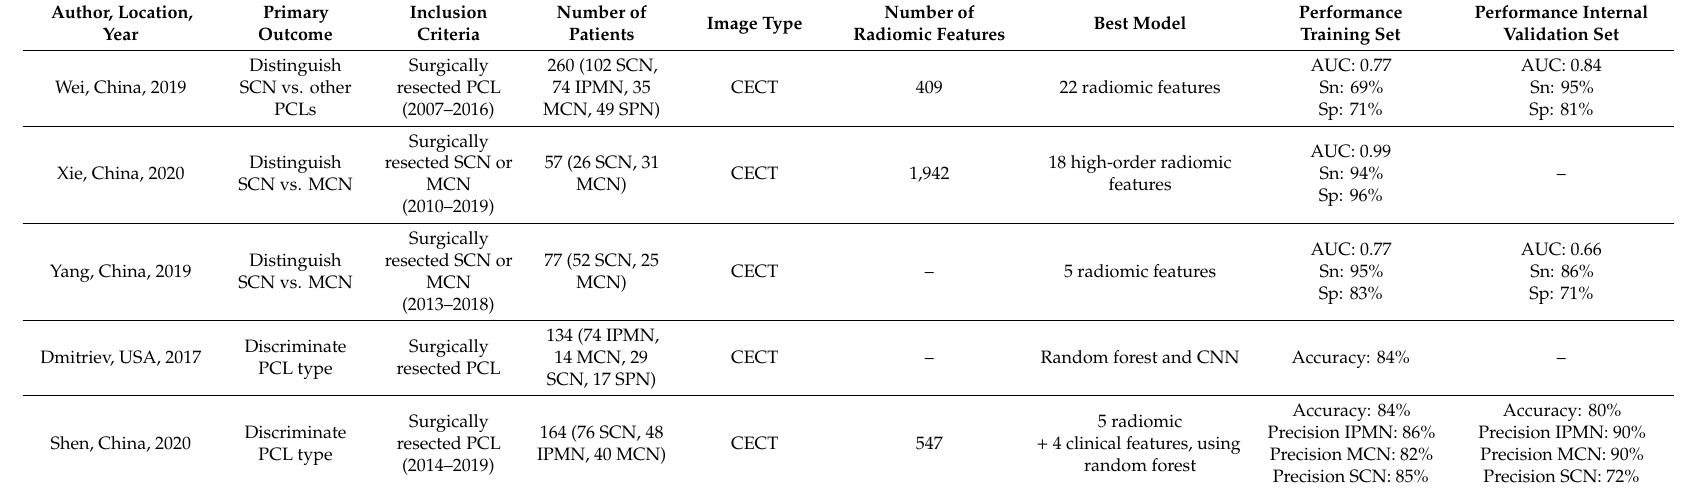
Table 2. Summary of studies evaluating the diagnostic role of radiomics on discrimination of PCL